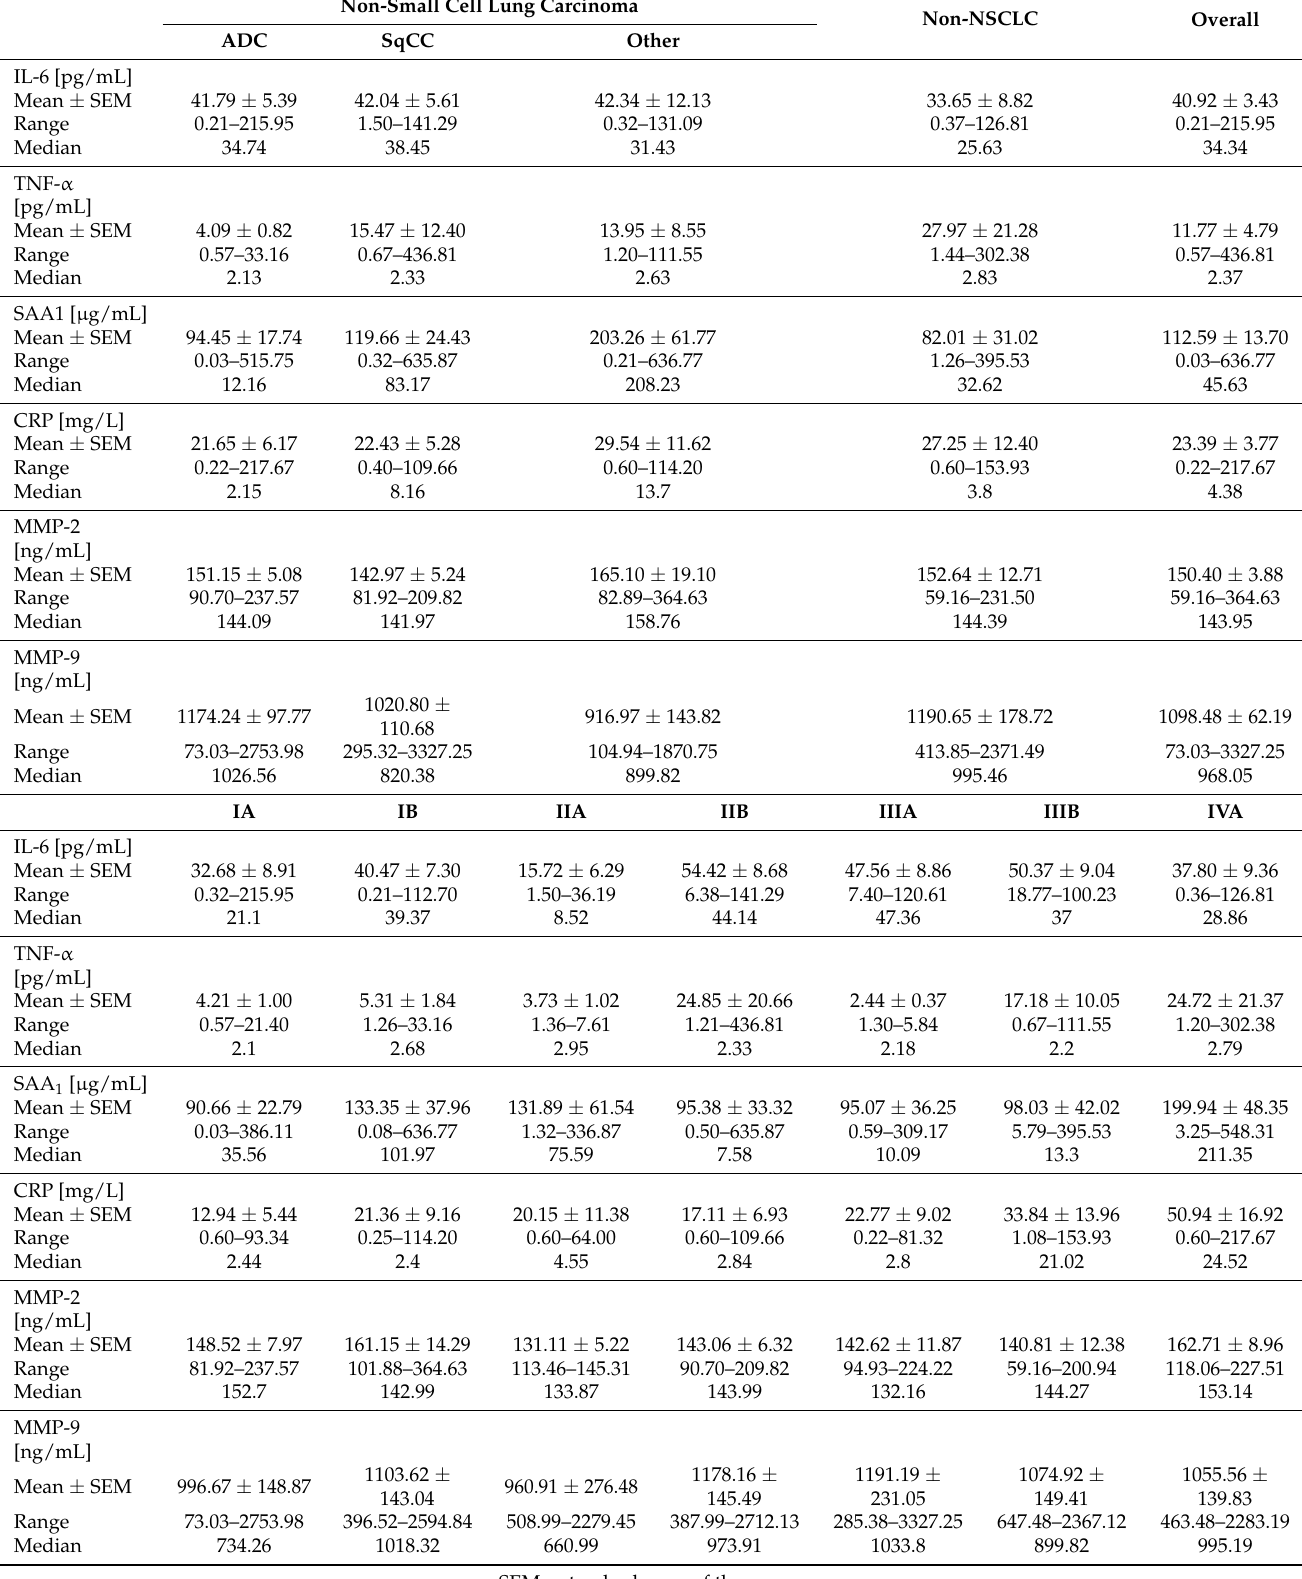
Table 3. Levels of the inflammatory markers according to lung cancer type, subtype, and